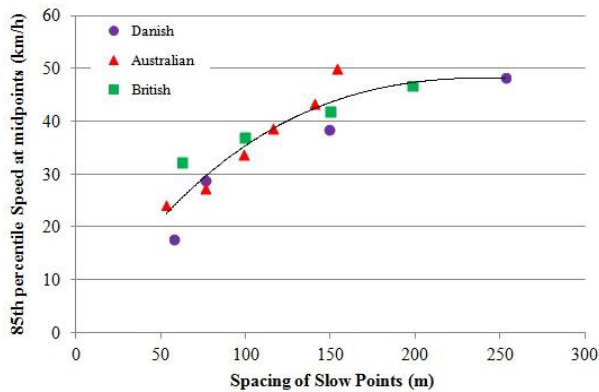
Figure 1. Speed at intermediate points (km/h) as a function of the distance (m) between slow points with data from various countries.